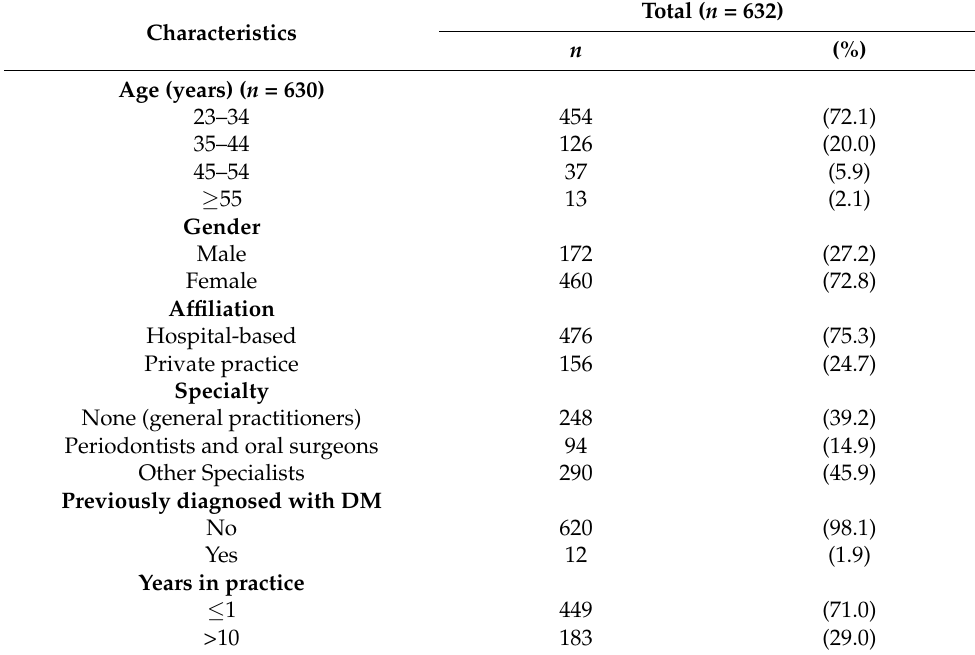
Table 1. General characteristics of